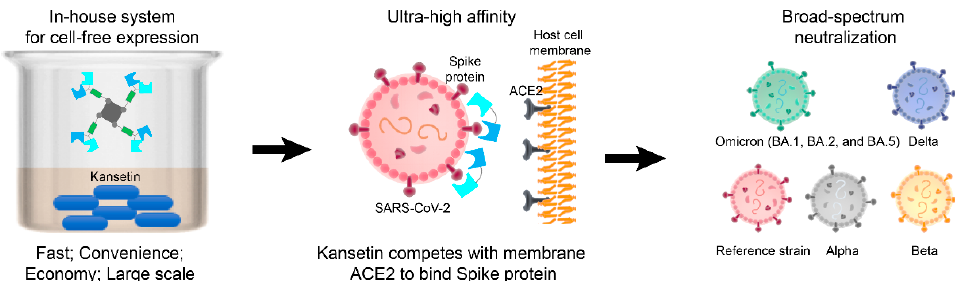
Figure 3. Schematic depiction of expression and strong SARS-CoV-2 neutralization of